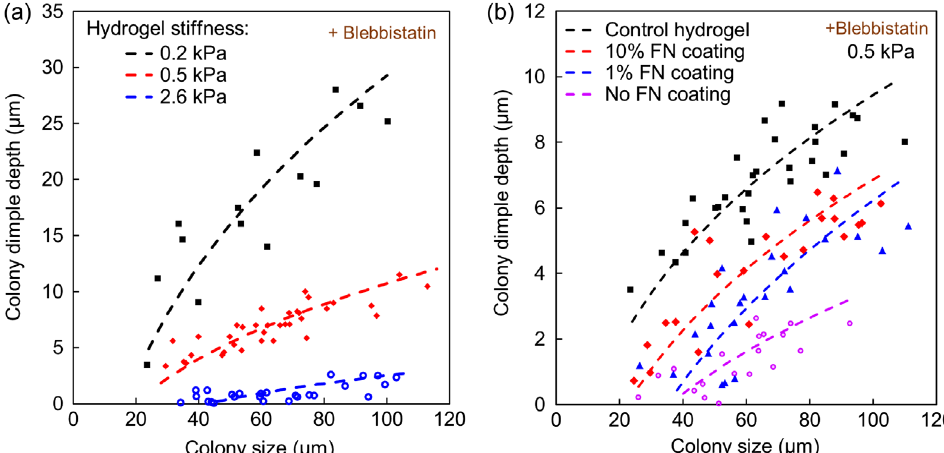
FIG. 2. HCT-8 colony dimpling into PAA gels driven by cell-hydrogel adhesion. (a) Hydrogel stiffness and size-dependent dimpling of the HCT-8 colonies. (b) Effects of fibronectin coating density on HCT-8 colony dimpling. Each group contains the combined data from three parallel experiments. Colony size is denoted as the equivalent diameter D ¼ ð 4 S= π Þ 1 = 2 , where S is the projected colony area. All the dashed lines are best-fit trend lines of the experimental data